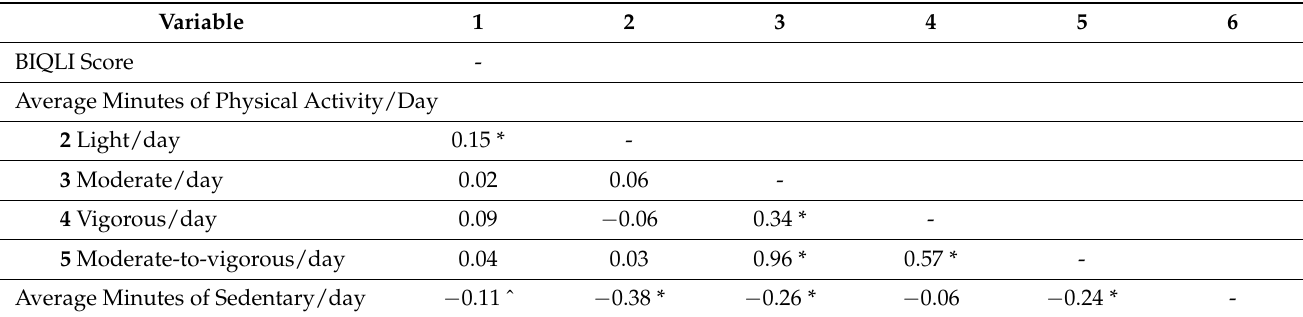
Table 2. Bivariate correlations between body image quality of life score, physical activity intensity levels, and sedentary time (average